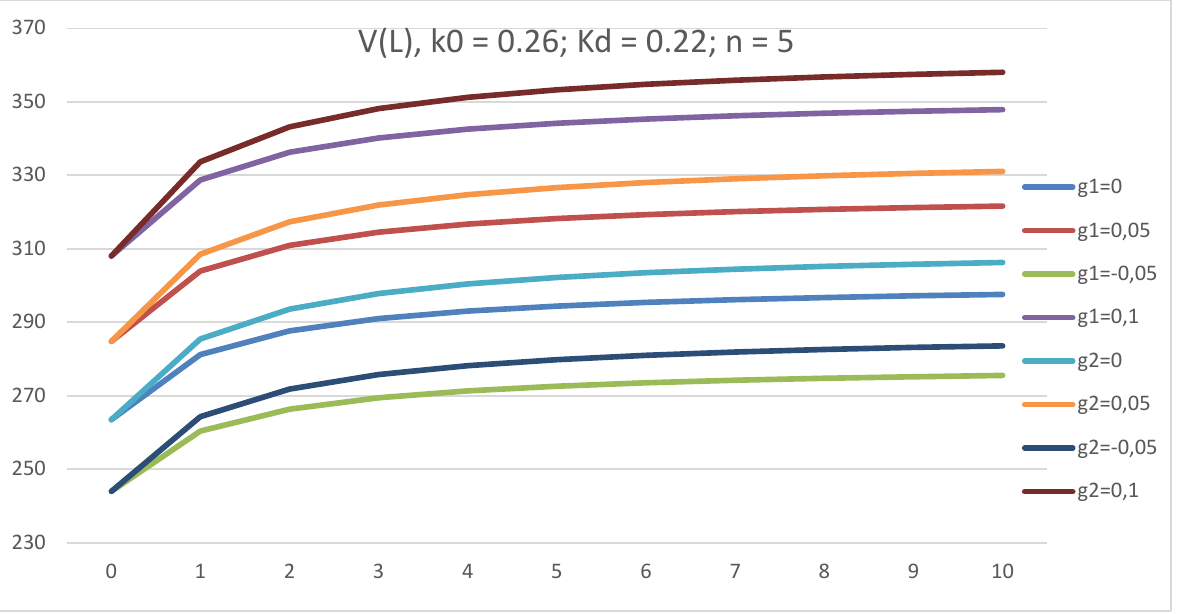
Figure 3. The dependence of discount rate, WACC–g, on leverage level L in GBFO theory with payments of tax on profit at the end of periods (1) and advance payments (2) at k 0 = 0.26; k d = 0.22; t = 0.2 g = 0.1; 0.05; 0.0; − 0.05, for a five-year company.